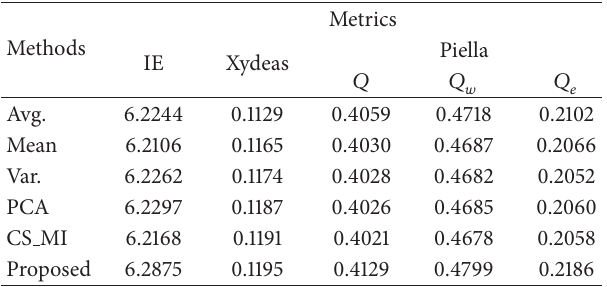
Table2:Thequantityassessmentoffusionmethodsforinfraredand visible light images.